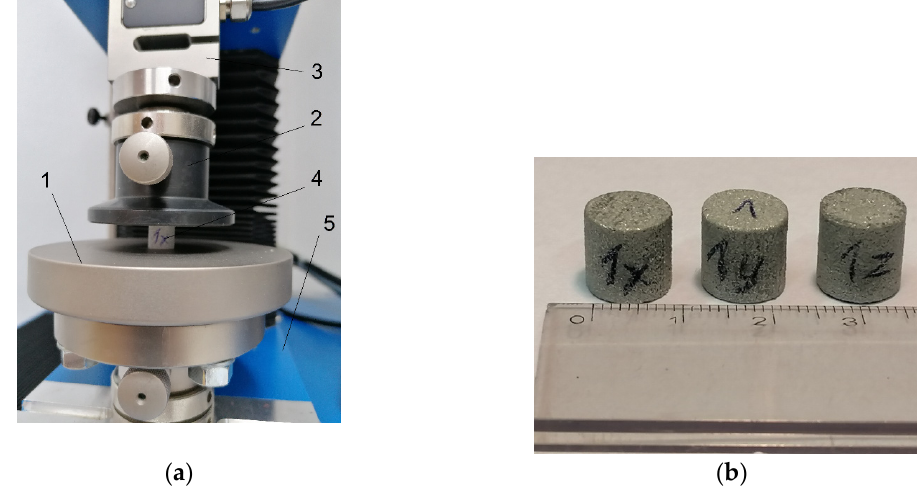
Figure 3. Specimens used in the stress relaxation tests; ( a ) specimen during the test (1—moving lower platen, 2—fixed upper platen, 3—strain gauge load cell, 4—specimen, 5—machine base); ( b ) specimens after the tests.